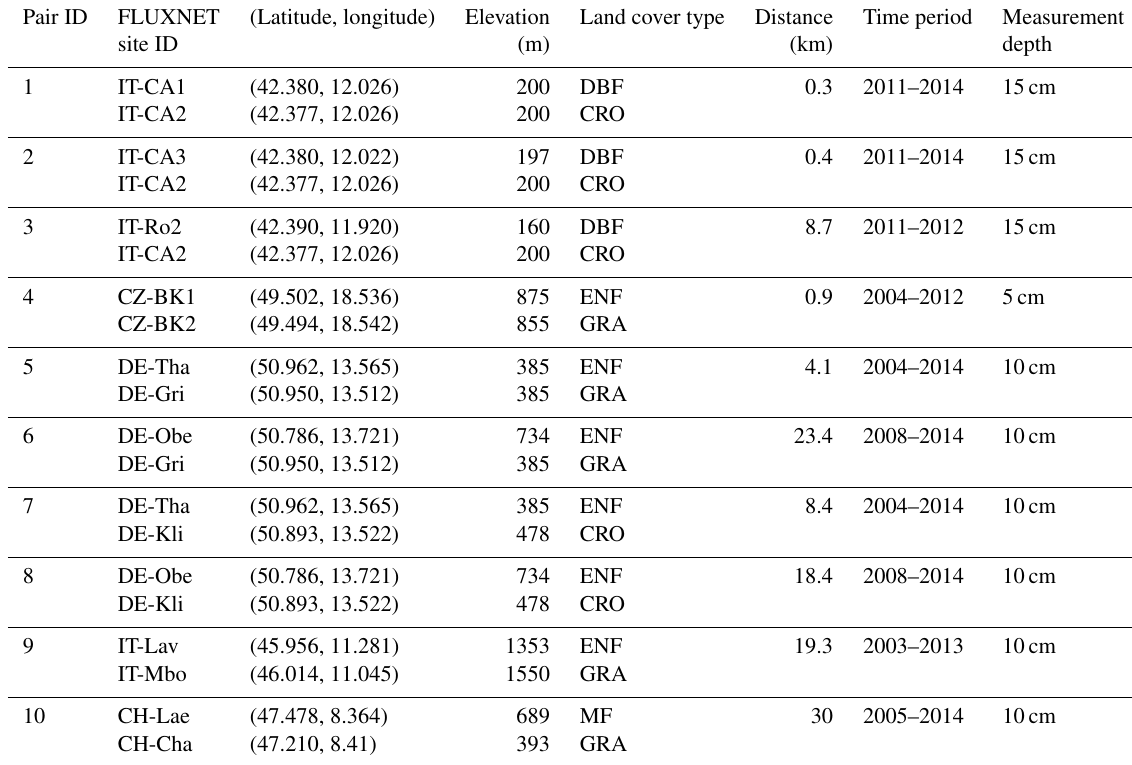
Table 2. Characteristics of the sites selected from FLUXNET2015 dataset. DBF – deciduous broadleaf forest; ENF – evergreen needleleaf forest; MF – mixed forest; CRO – cropland; GRA – grassland, as described by the International Geosphere-Biosphere Programme (IGBP) classification